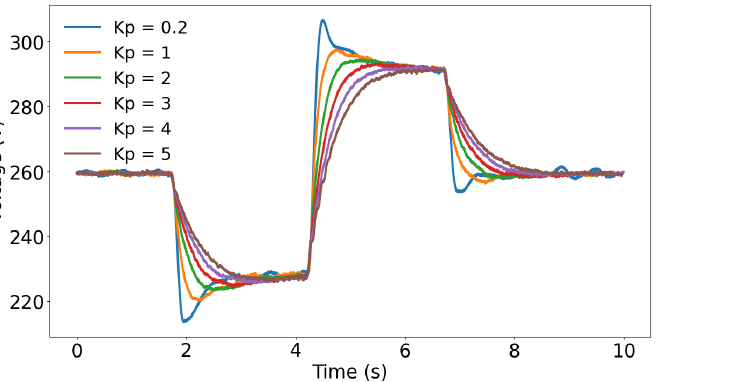
Figure 15. System voltage disturbance with a triangular feedforward signal, different K p and T i =